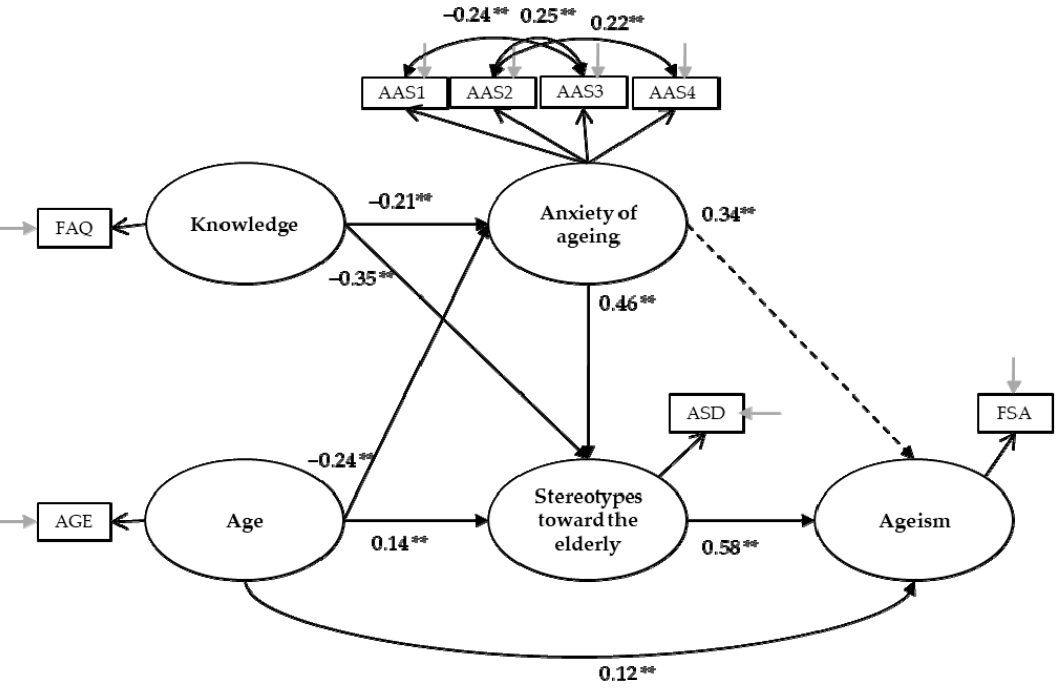
ffi cients estimates (** p <